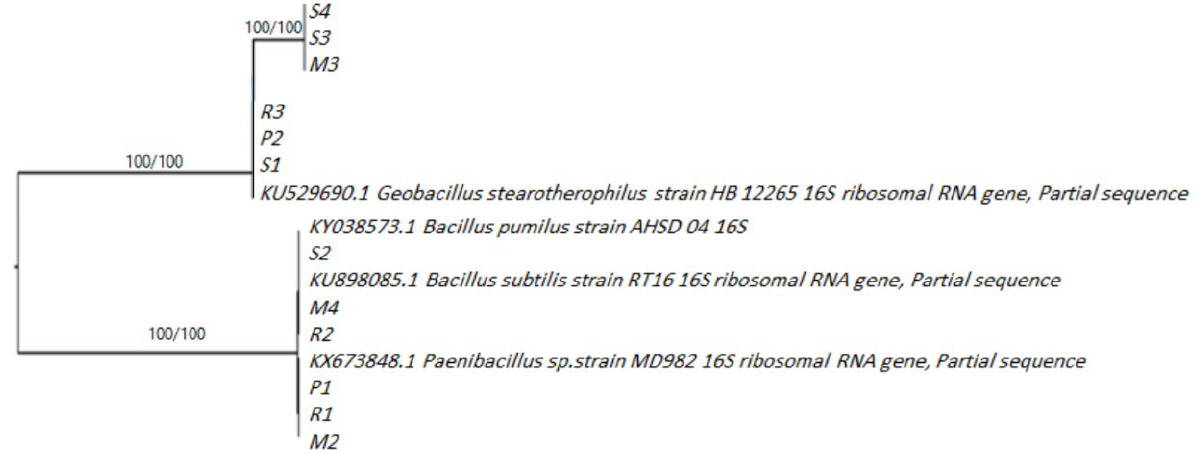
Figure 2. Phylogenetic relationships of 12 isolates belongs to the four references bacteria species based on 16S rDNA gene sequences. S2 represents Bacillus pumilus; M4 and R2 represent Bacillus subtilis; P1, R2 and M2 represent Paenibacillus spp. and S1, P2, R3, M3, S3, S4 represent Geobacillus stearothermophilus . The branching pattern was generated by the neighbor-joining method. Bootstrap values are indicated at the